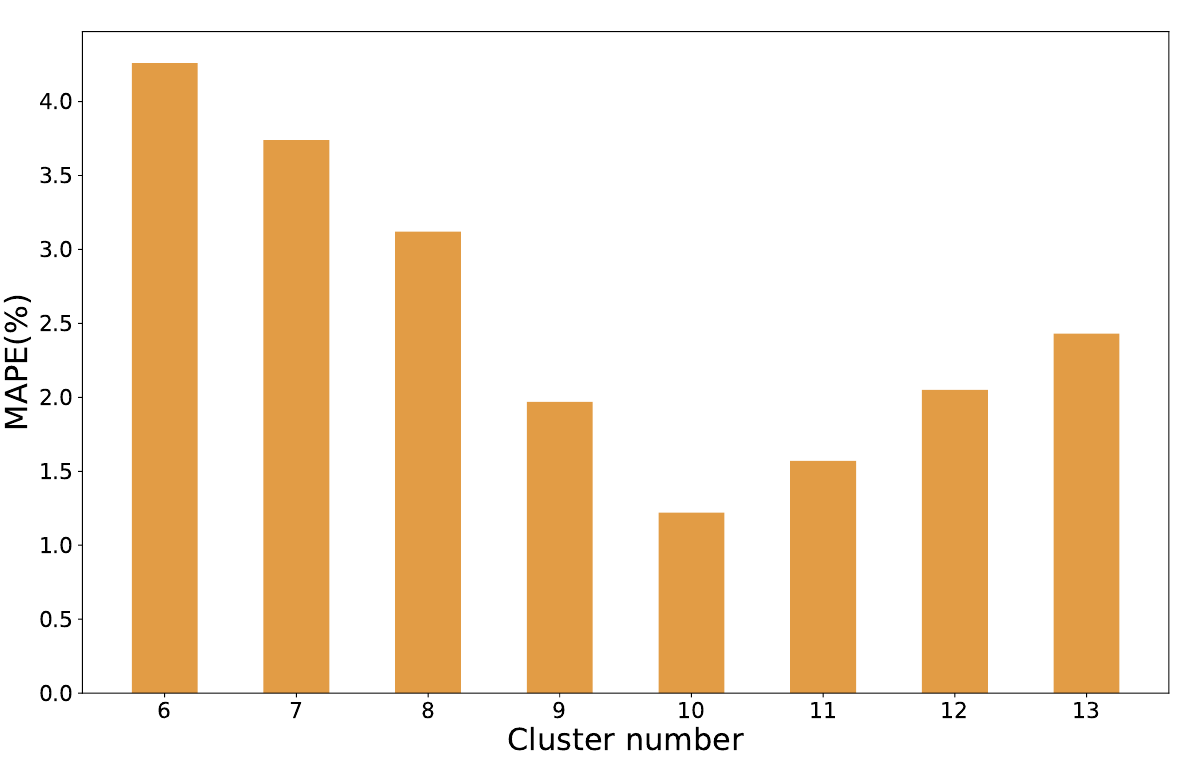
Figure 10. MAPE (%) for various cluster